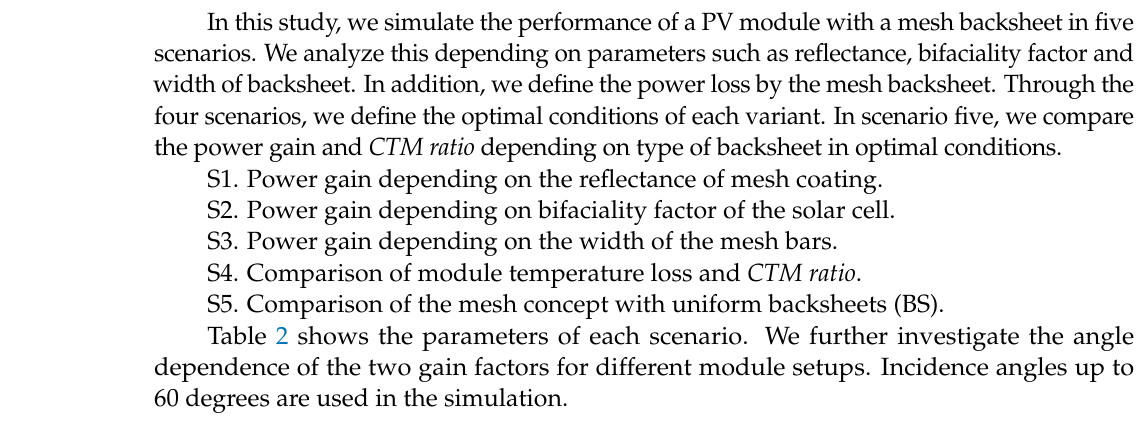
Table 2. Variants of each